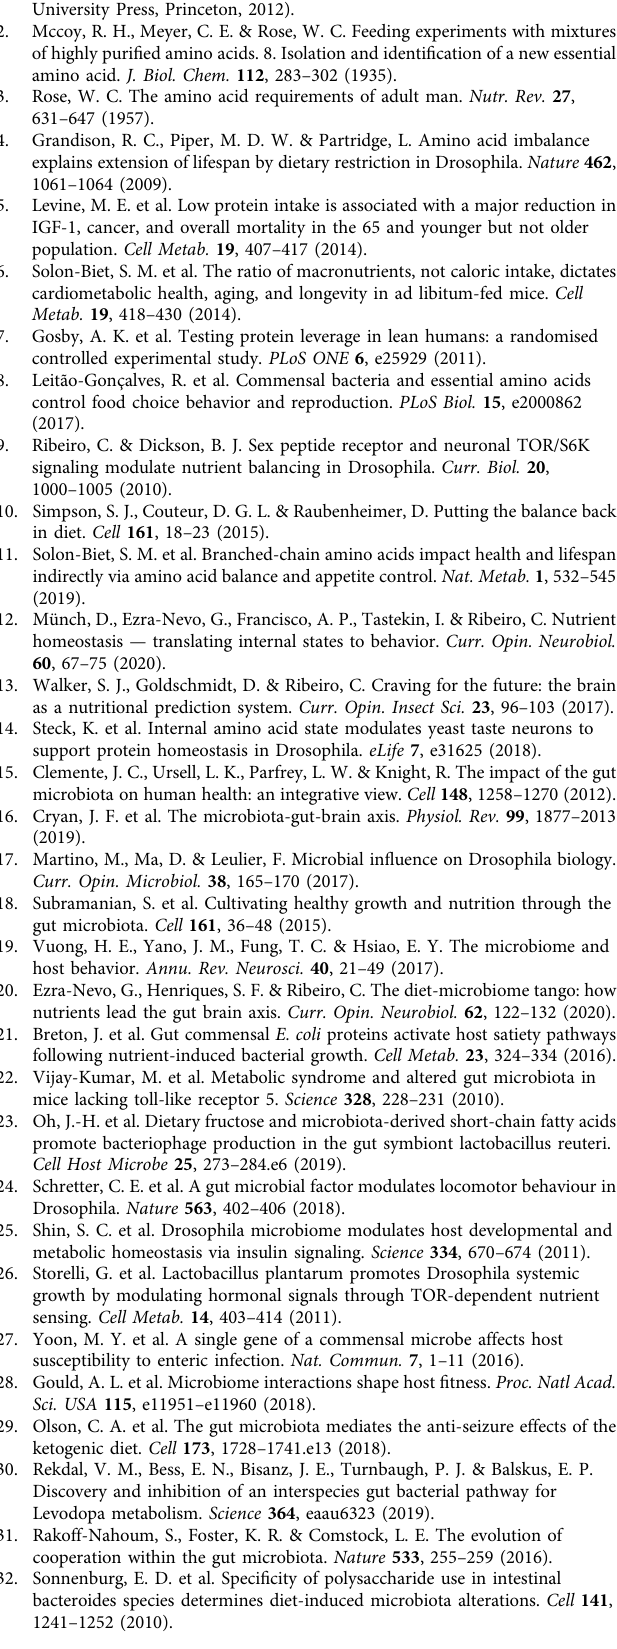
Table 1 Parameters used for the pre-processing of raw metabolite peaks using